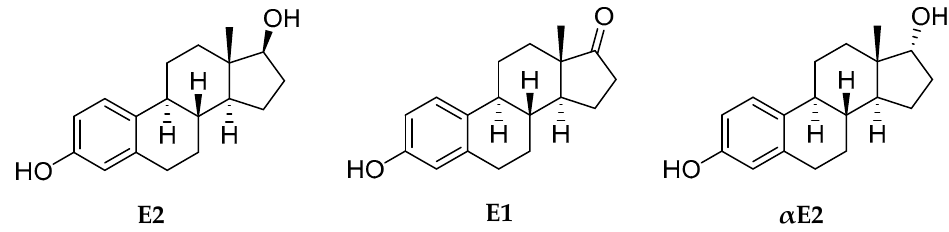
Figure 1. Chemical structure of 17 β -estradiol (E2), estrone (E1) and 17 α -estradiol ( α E2).